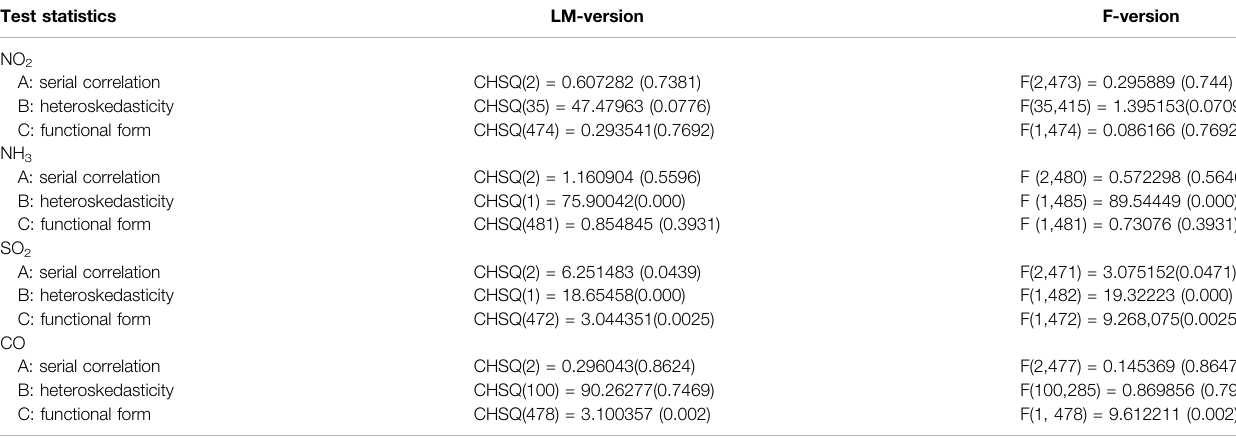
TABLE 6 | The results of the autoregressive distributed lag diagnostic